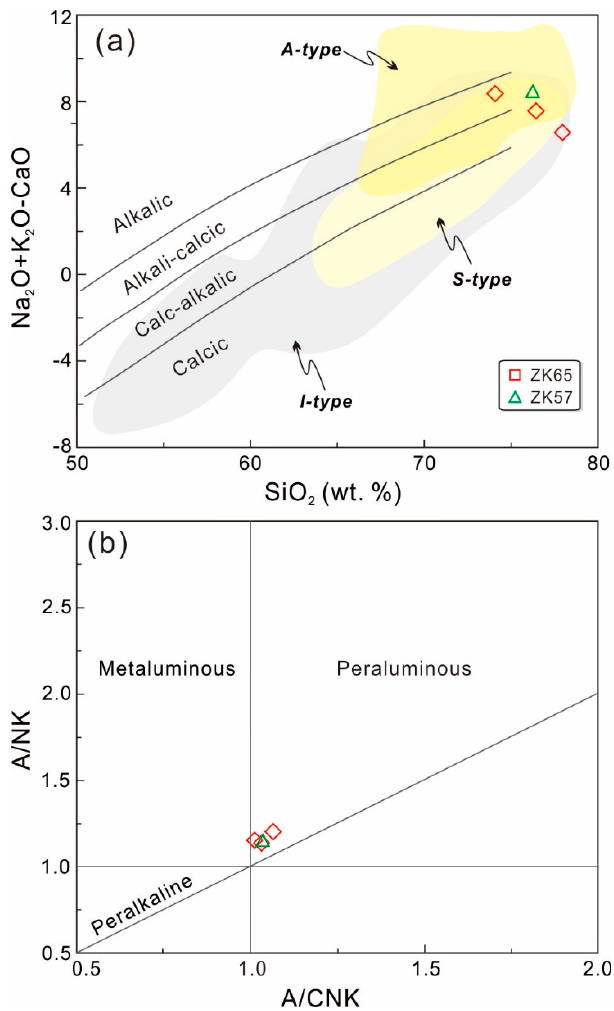
Figure 4. ( a ) Diagram of SiO 2 vs. Na 2 O + K 2 O − CaO [56]; ( b ) Diagram of Al/(K+Na) vs. Al/(Ca + K